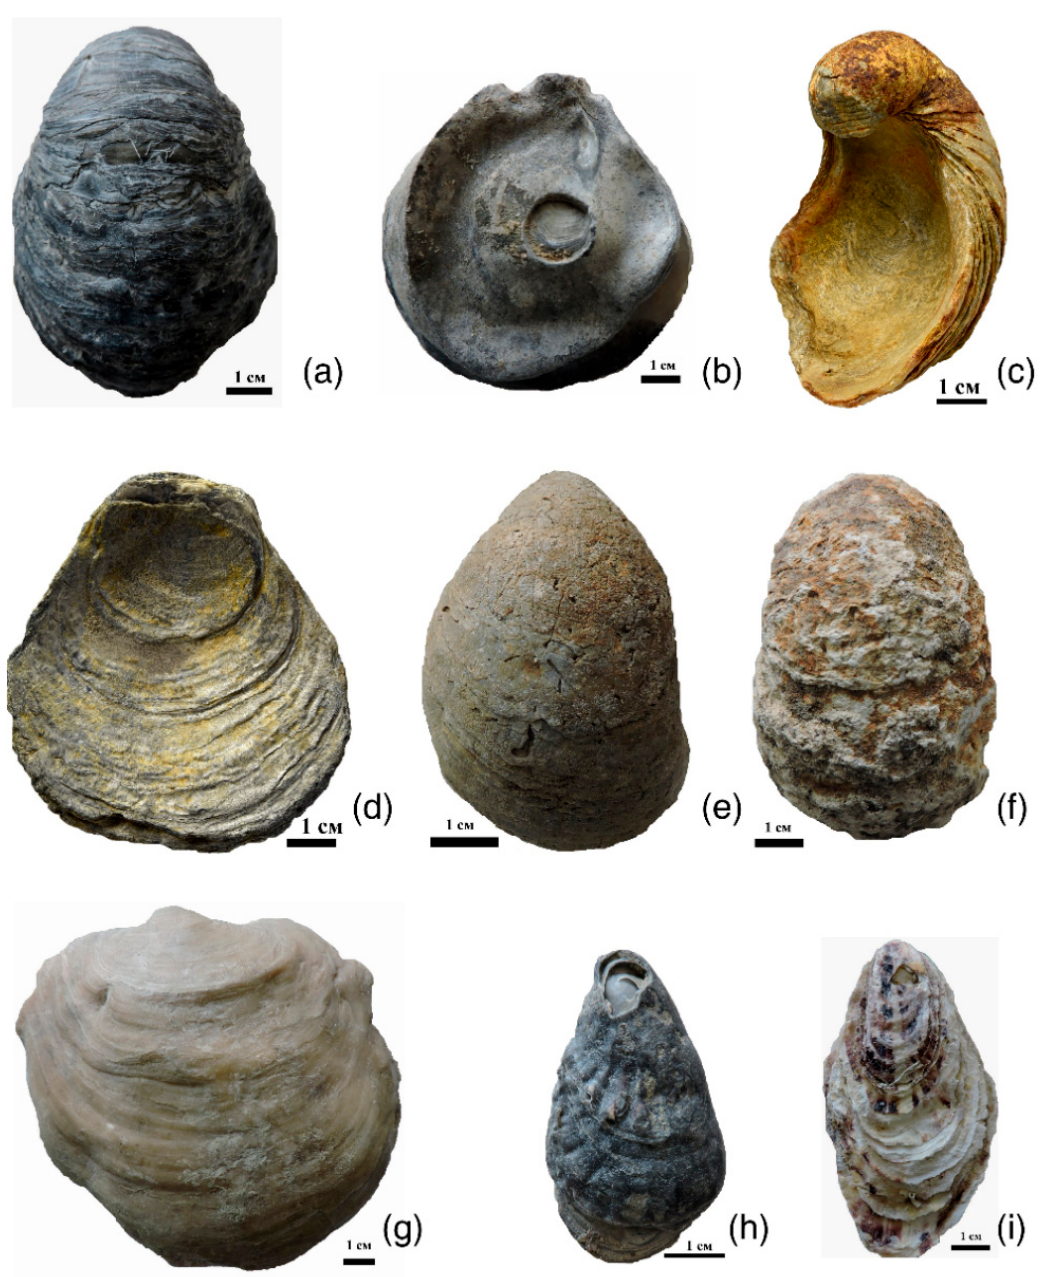
Figure 2. Valves of studied Gryphaea dilatata Sowerby, 1816: ( a ) left valve, ( b ) right valve, Kursk region, near Zheleznogorsk, Mikhailovsky quarry, Middle Jurassic, Middle–Upper Callovian; ( c ) left valve, ( d ) right valve Oryol region, Kromy district, sand quarry near the village of Sukhochevo, Middle Jurassic, Middle Callovian; ( e ) left valve, Moscow region, Shatura district, sand quarry on the outskirts of the town of Roshal, Middle Jurassic, Callovian–Upper Jurassic, Lower Oxfordian; ( f ) left valve with a white friable layer on the surface, Oryol region, Kromy district, sand quarry near the village of Sukhochevo, Middle Jurassic, Middle Callovian; ( g ) left valve of Pycnodonte mirabilis Rousseau, 1842, Crimea Peninsula, Upper Cretaceous, Maastrichtian; ( h ) right valve of Ostrea edulis Linnaeus, 1758, the coast of the Arabatsky Gulf of the Azov Sea in the town of Shchelkino (Crimea Peninsula), Pleistocene, Karangat deposits; ( i ) right valve of Ostrea edulis Linnaeus, 1758, coast near the village of Maly Utrish, Black Sea, recent.